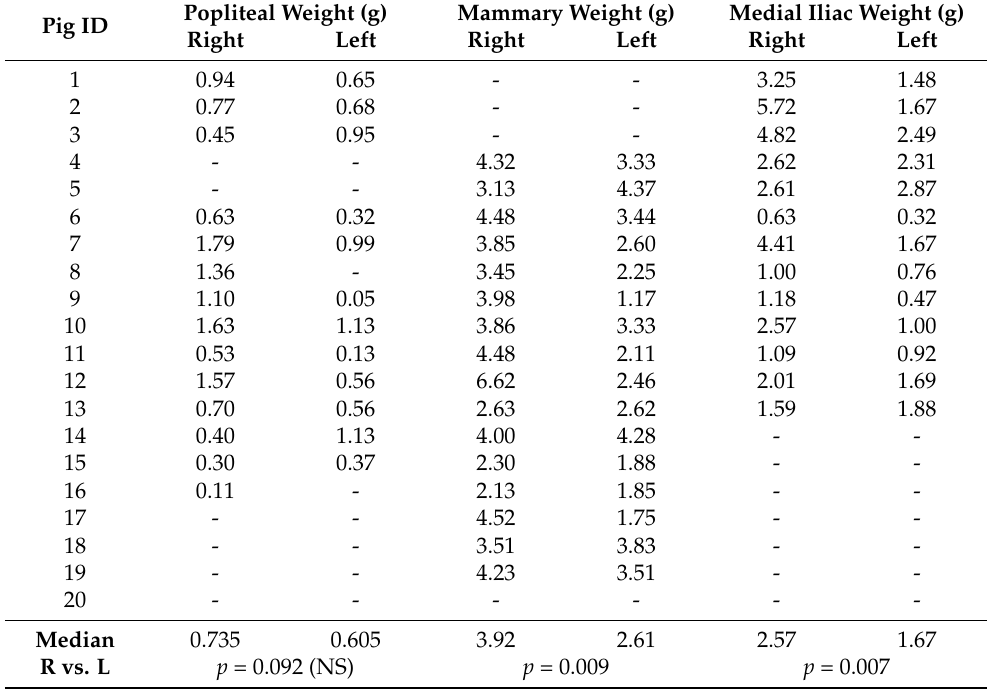
Table 2. Lymph node